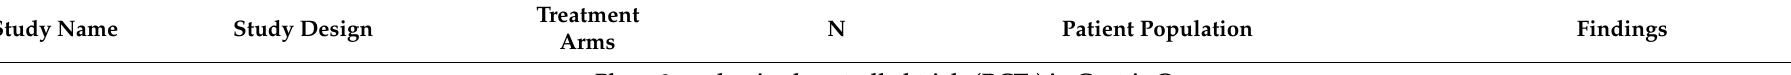
Table 1. Summary of survival data from phase 3 clinical trials investigating the use of ramucirumab treatment in patients with gastrointestinal (GI)